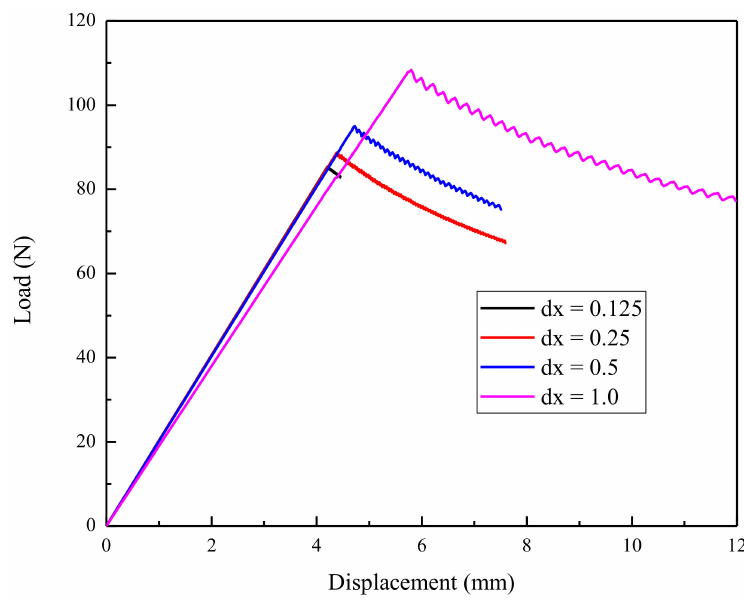
Figure 11. Influence of different grid spacing, PD modeling load–displacement.